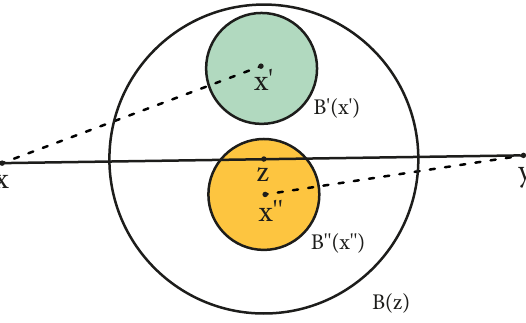
Figure 1: Linking x and y via B ′ ( x ′ ) and B ′′ ( x ′′ ) , balls of radius σ /9 , both contained in the ball B ( z ) of radius σ /3 . Along the dashed lines we use Harnack chains to get bounds for the Green function in the proof of Proposition 2.7 “bound for the Green